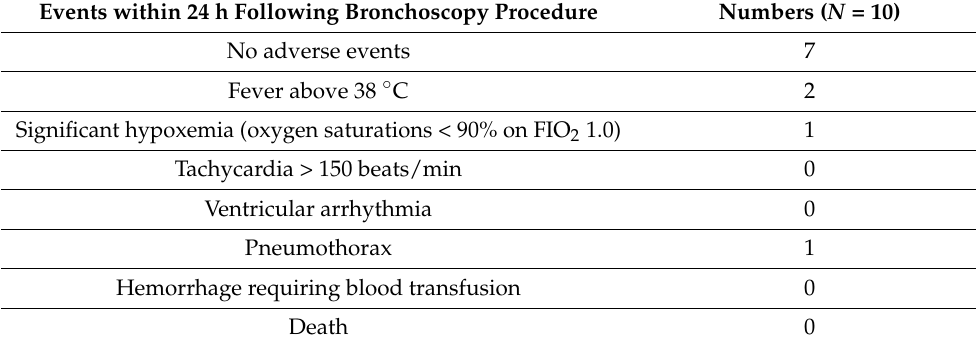
Table 3. Incidence of adverse